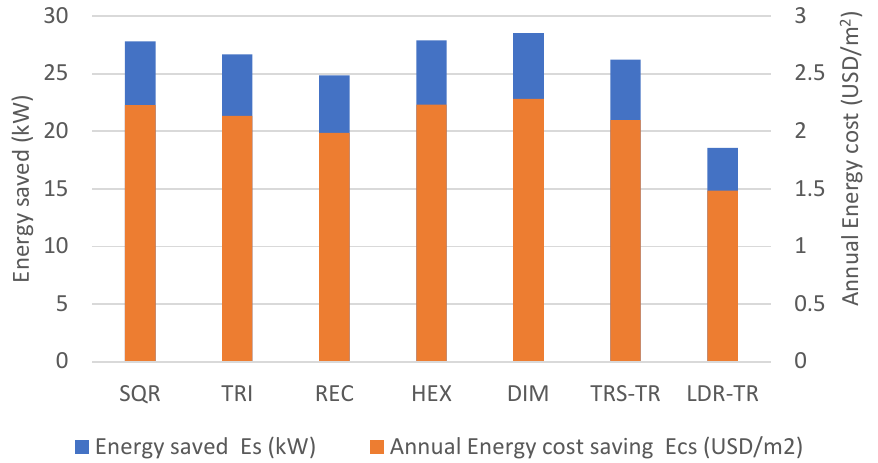
Figure 12. Energy saved and associated electricity cost reduction ($0.08/kWh) using different 3DPC infill structures versus red clay brick wall.